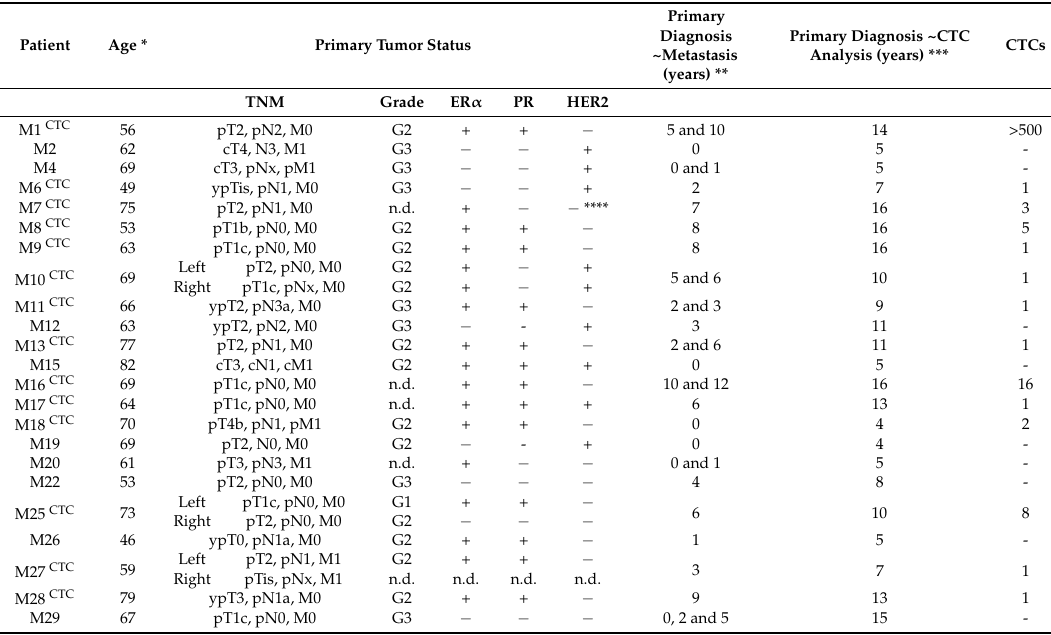
Table 2. Patient characteristics and CTC